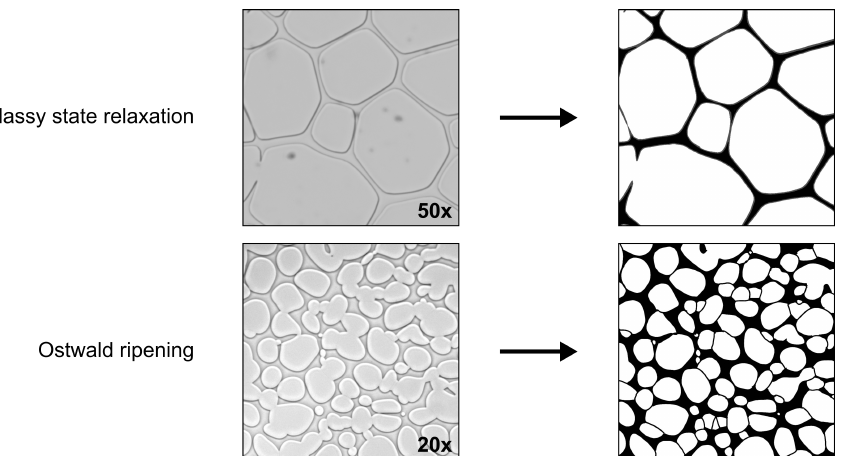
Figure 3. Labelling and evaluation of FDM pictures for the determination of glassy state relaxation and Ostwald ripening. Images for glassy state relaxation were taken after refreezing an annealed sample to − 50 °C, whereas Ostwald ripening data were gathered at the annealing temperature. Ice and matrix fractions are shown in white and black,